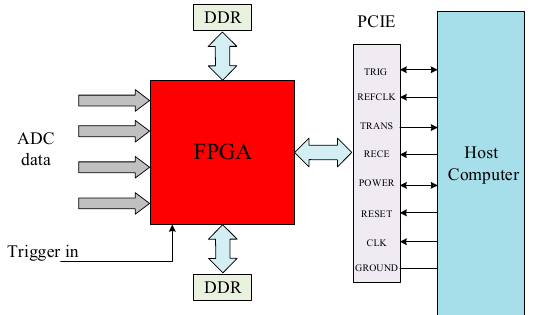
Figure 7. The schematic diagram of data acquisition and transmission.